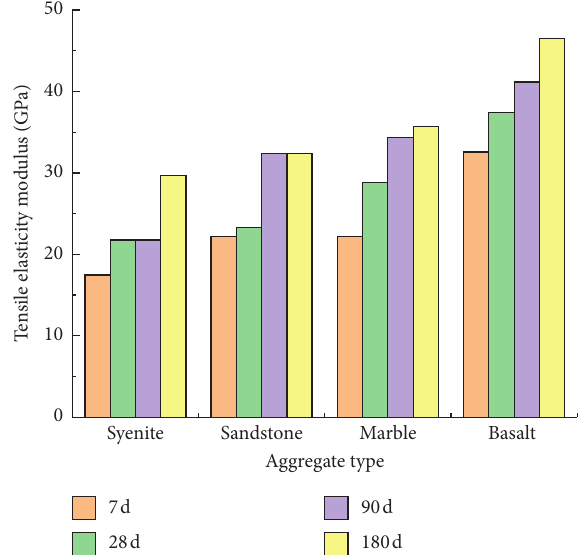
Figure 2: The tensile elasticity modulus of four types of aggregate concrete.